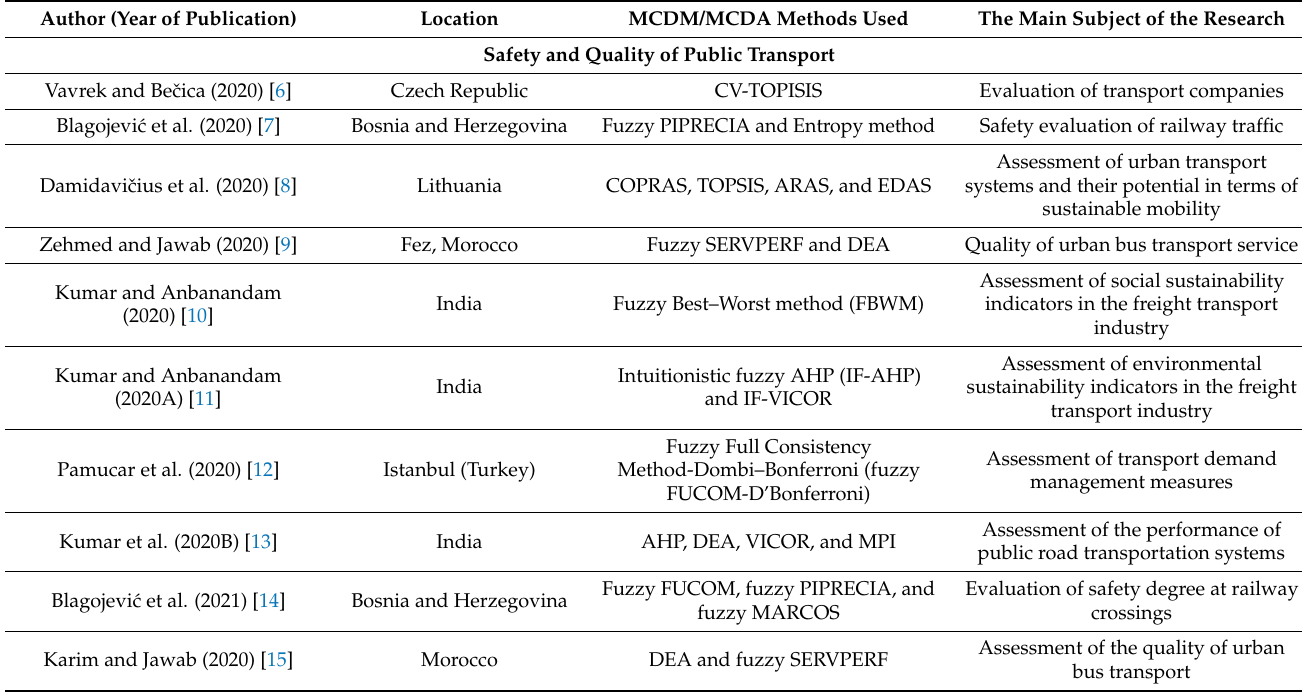
Table A1. Compilation of the literature review on multi-criteria methods applied in transport-related projects in 2020–2021. Author (Year of